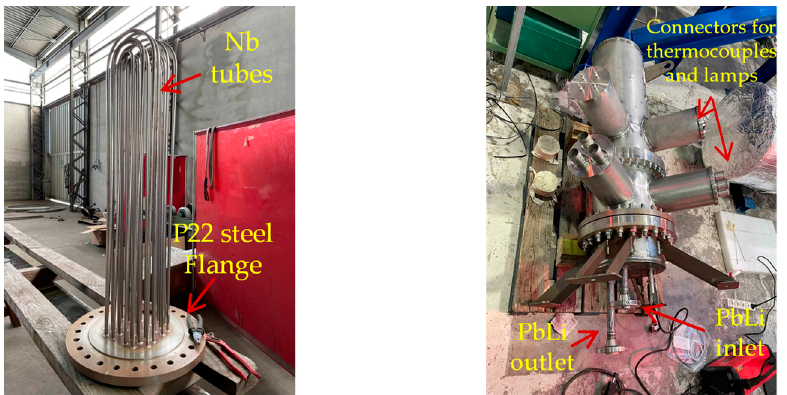
Figure 2. Pictures of the PAV mock-up at the end of the manufacturing. The three installed HPSs measure the hydrogen partial pressure in different locations of the facility: upstream of the saturator, between the saturator and the PAV mock-up, and downstream of the PAV mock-up. The sensors are labeled HLM 733, HLM 734, and HLM 735 and are indicated by Prussian blue boxes in Figure